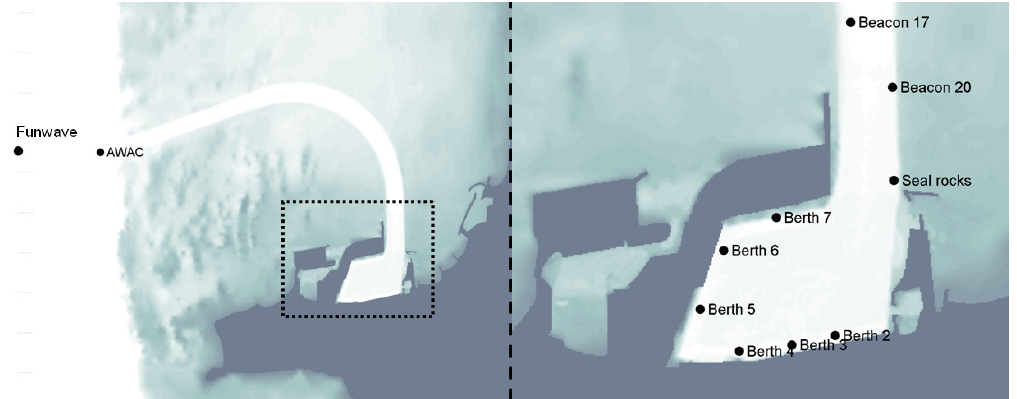
Figure 1. Port Geraldton (Western Australia). Bathymetry and location of gauges used in this study.